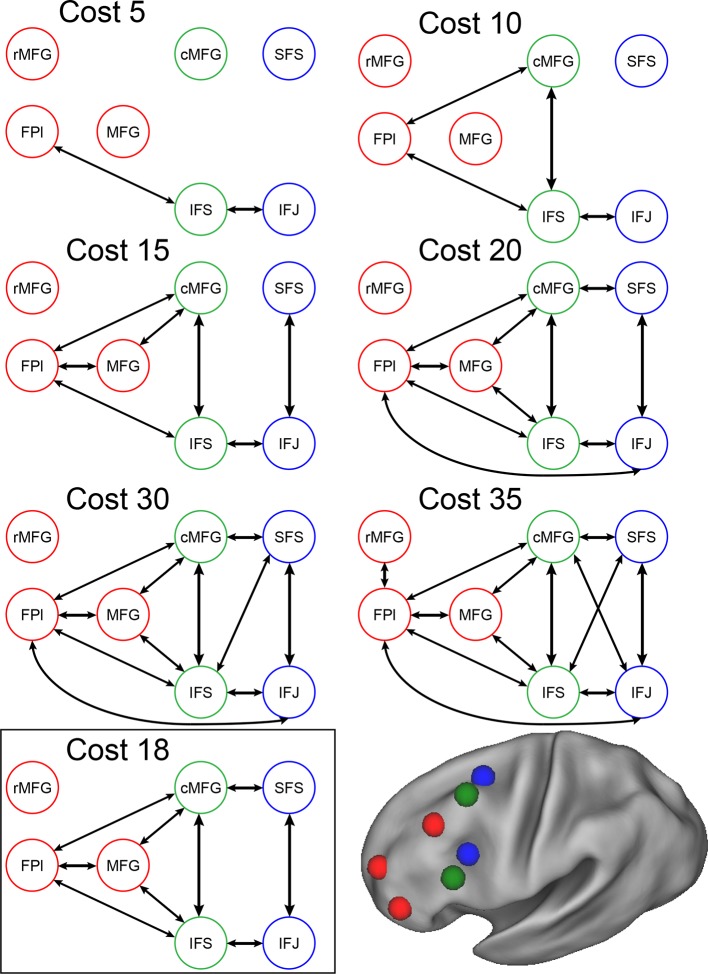
Connectivity as a function of cost.Examples of connectivity profiles at different costs are depicted. The chosen connectivity profile was at cost 18, falling in the middle of the sampling range. rMFG was disconnected from the rest of the network at all but the highest cost levels and was therefore excluded from various analyses.